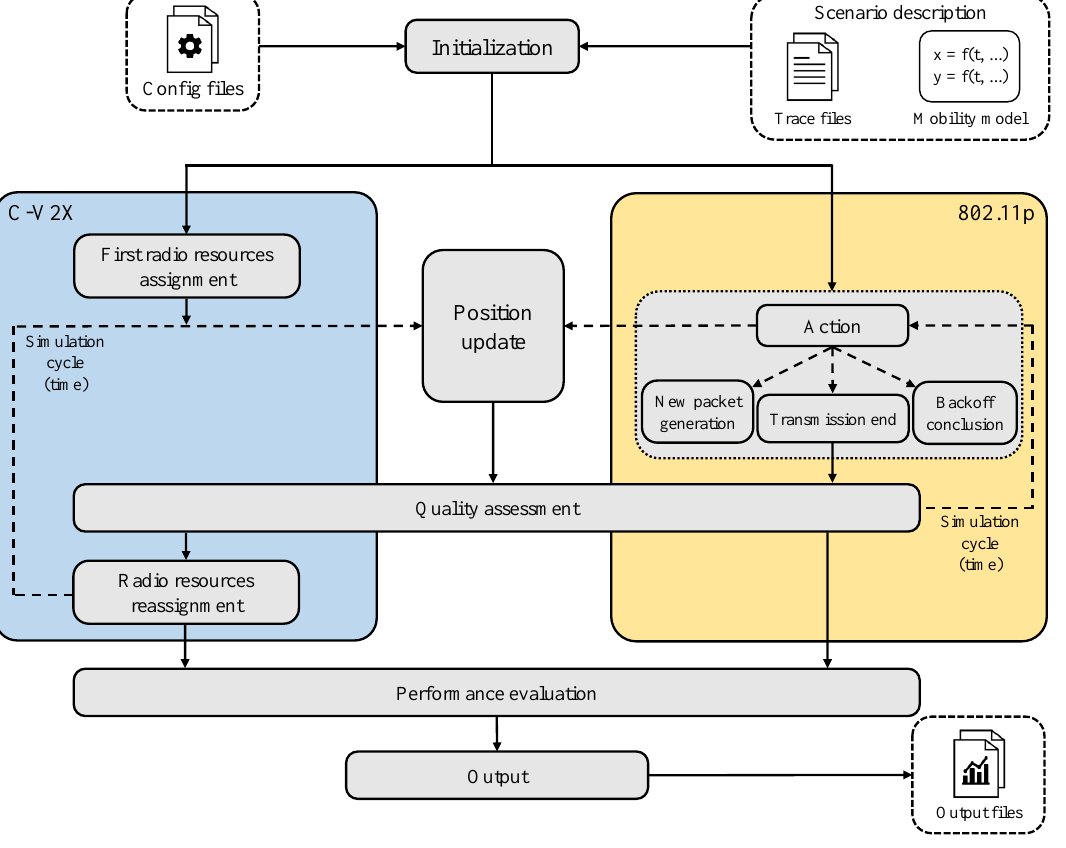
Figure 1. LTEV2Vsim block